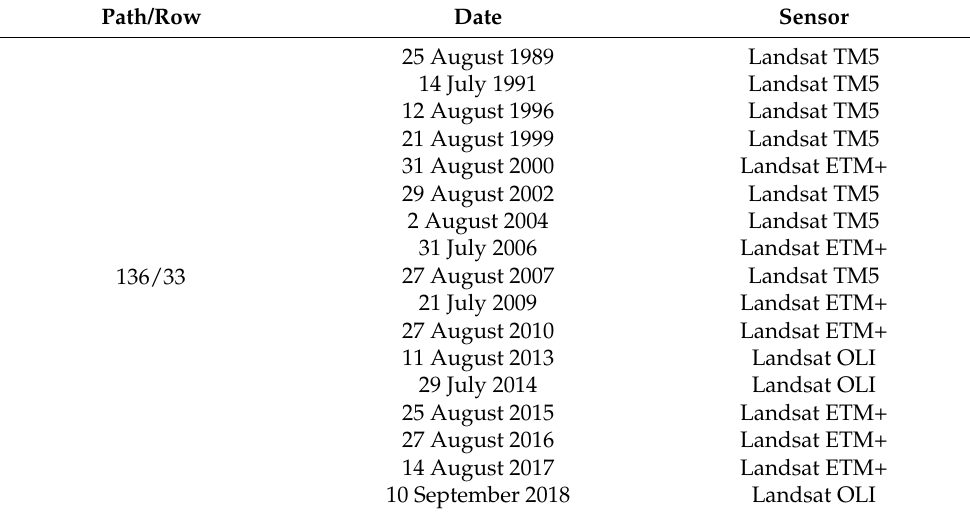
Table 1. Screened Landsat data that were used to determine the SLA in the Qilian Mountains during the 1989–2018